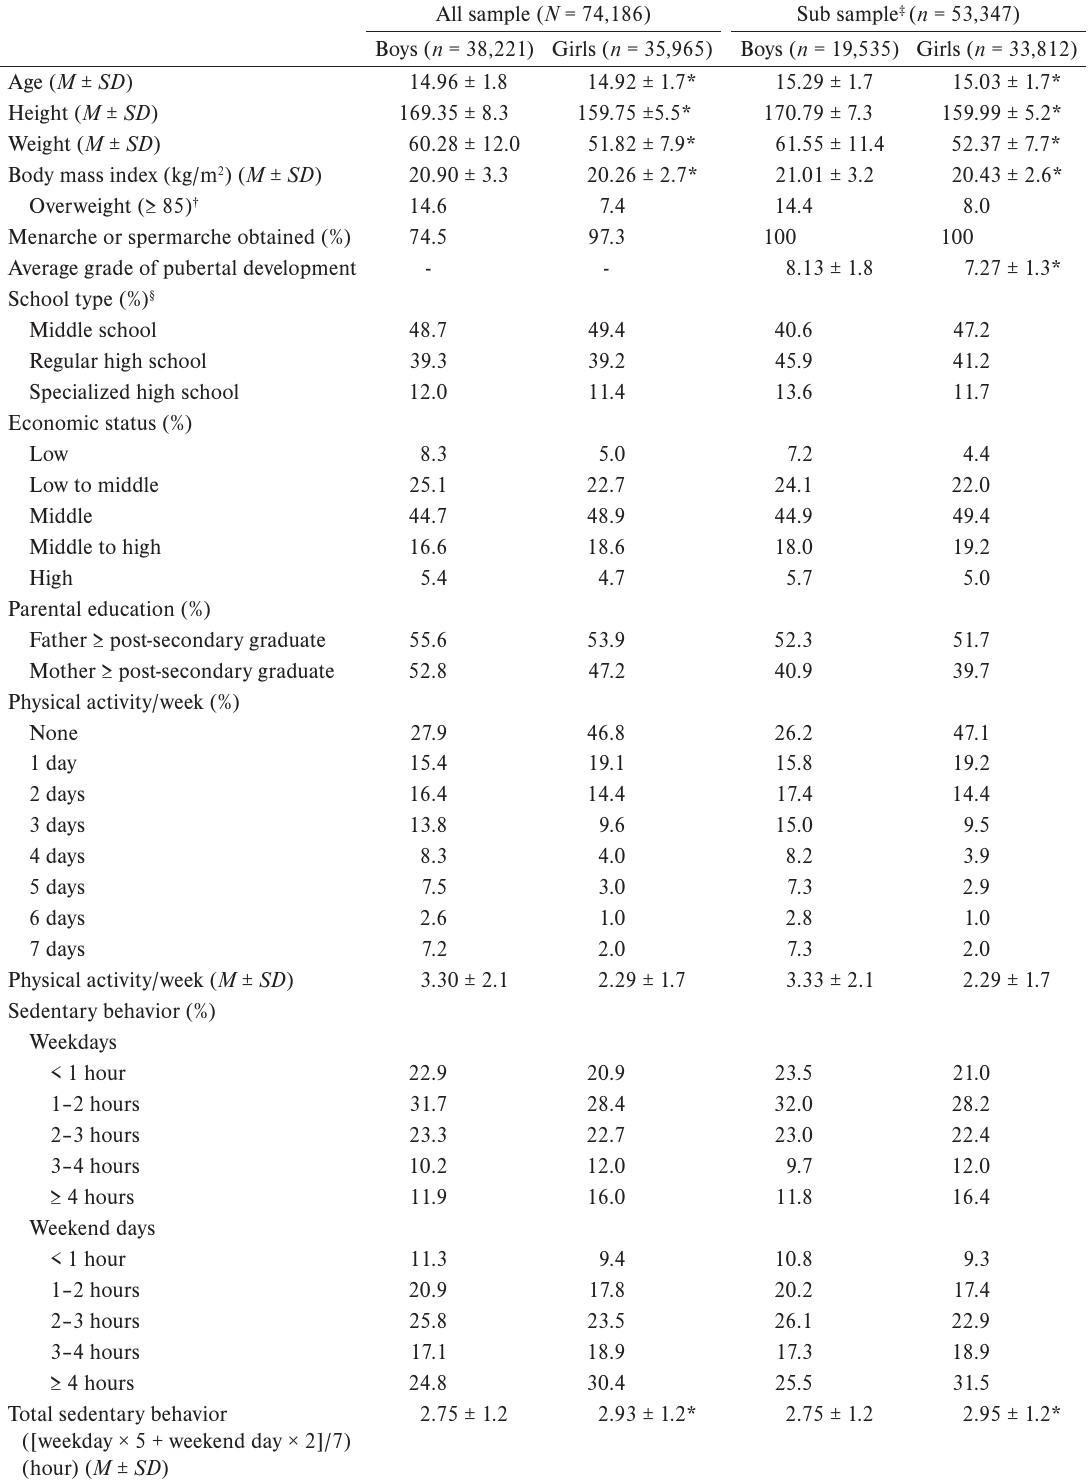
Sample characteristics by sex – Korea Youth Risk Behavior Web-based Survey,